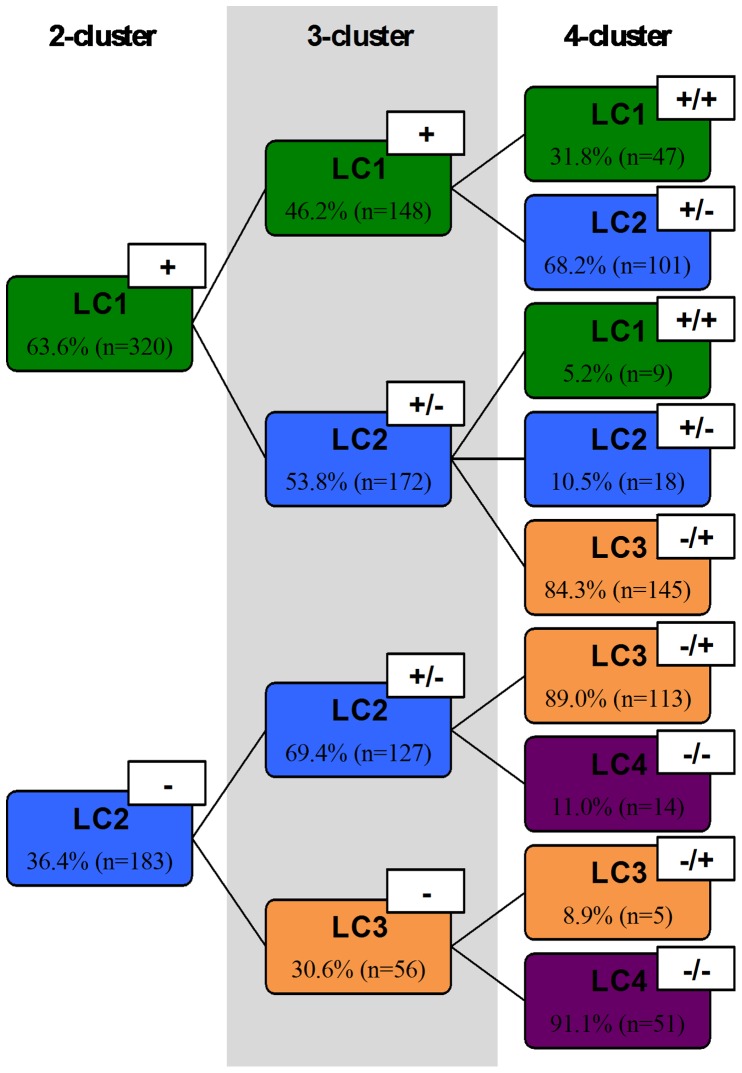
Schematic representation of the latent class membership distribution across the 2-, 3- and 4-cluster LCA solutions based on cross tabulation analysis.Frequency counts and percentages of subjects are reported for each latent class in each cluster solution.